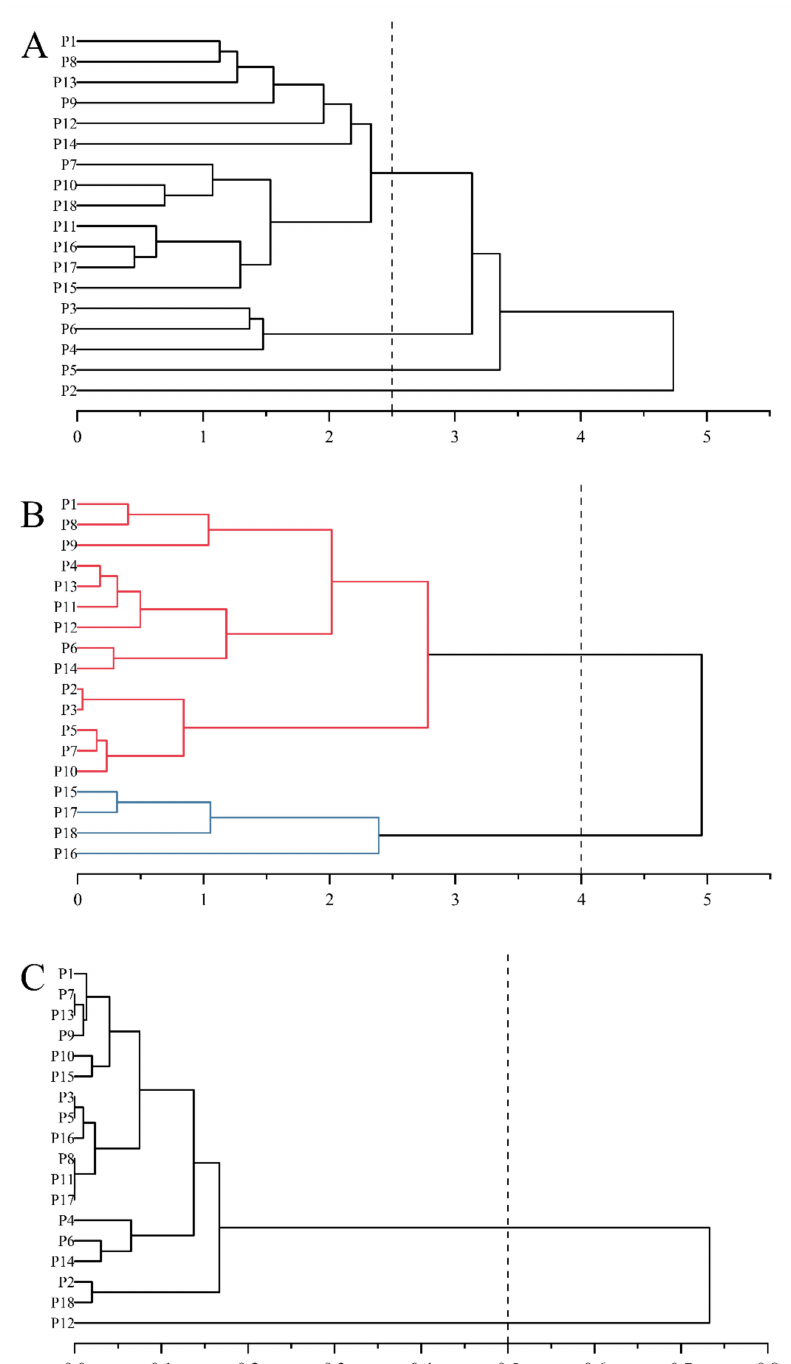
Figure 5. Cluster analysis of 18 tree peony populations based on PC1 ( A ), PC2 ( B ), and PC3 ( C ), respectively. The red line indicates subsect. Vaginatae and the blue line indicates subsect. Delavayanae